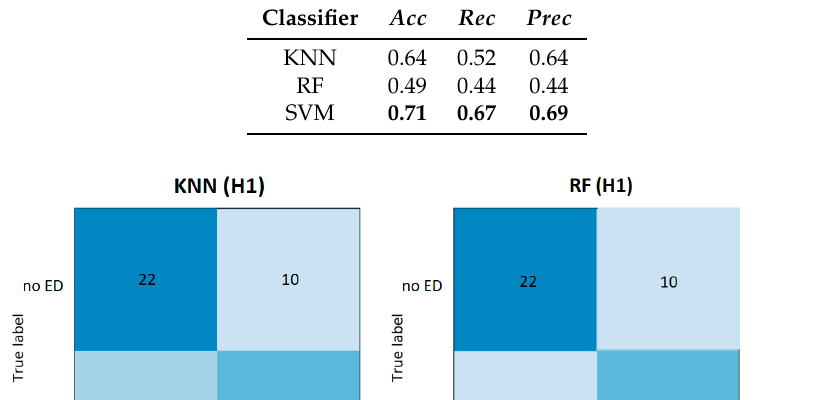
Table 4. Investigation of H2: Classification performance obtained when classifying photoplethysmography and anthropometric features with KNN, Random Forest (RF) and SVM classifiers. Classification accuracy ( Acc ), recall ( Rec ) and precision ( Prec ) are reported.